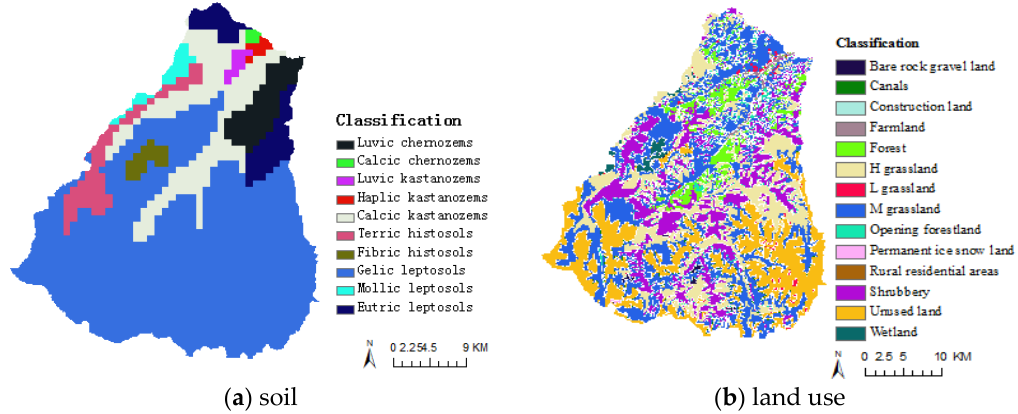
Figure 2. Distributions of soil and land use in the Xiying River basin. ( a ) soil distribution; ( b ) land use distribution from 1990. Table 1. Land use classification (%) of the Xiying River basin in 1990, 2000, and 2008.